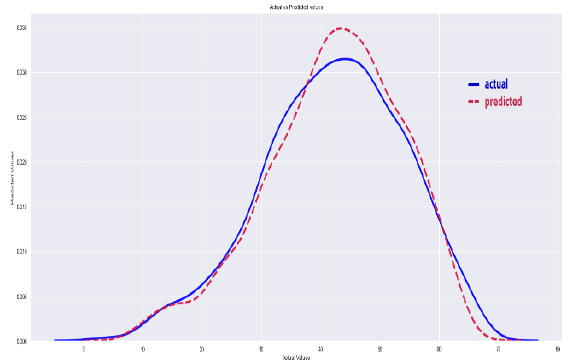
Fig. 6. Actual vs Predicted for Module Temperature using Random Forest Regression